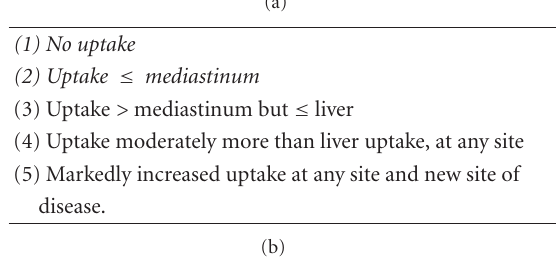
Table 1: Score 3 might be either considered as FDG-PET positive when a therapy decrease is planned in localised cHL or negative when treatment intensification is planned in advanced cHL.